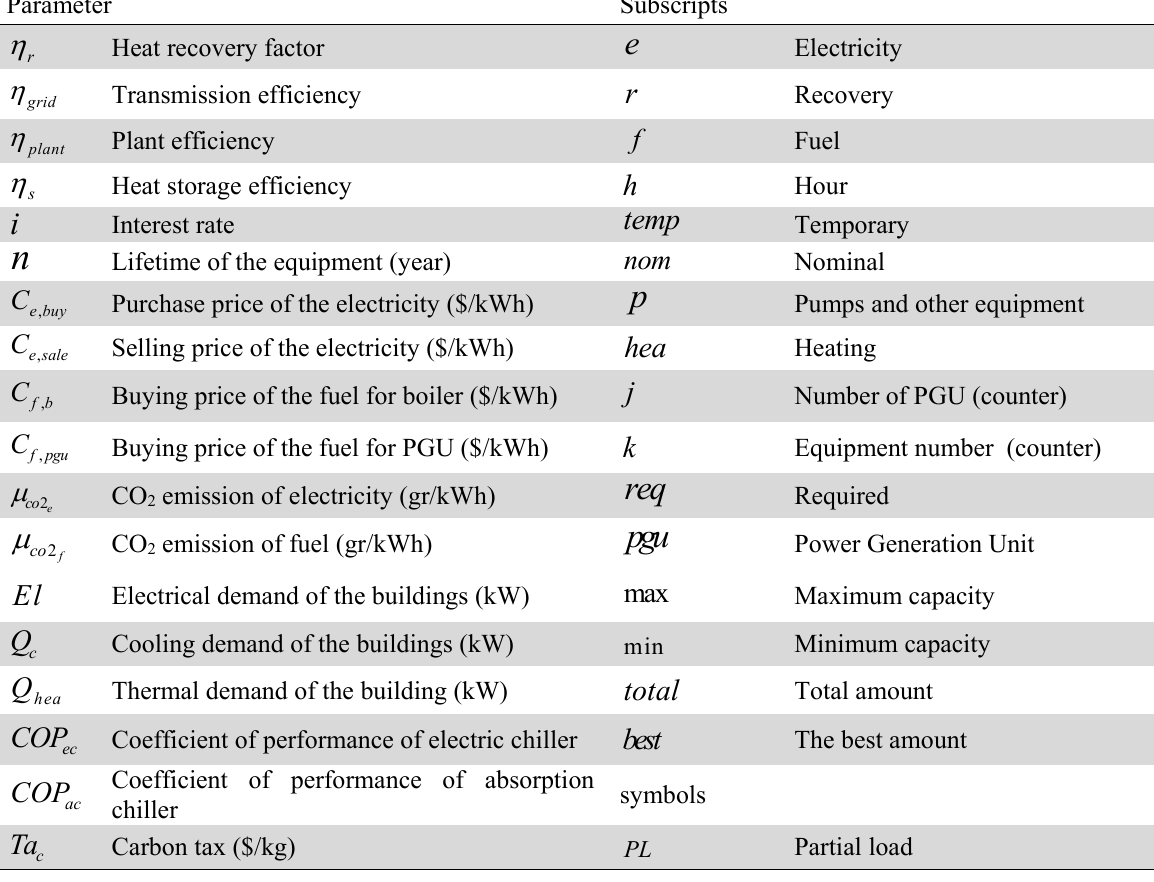
Parameters and symbols of the developed model Parameter Subscripts  Heat recovery factor e r Transmission